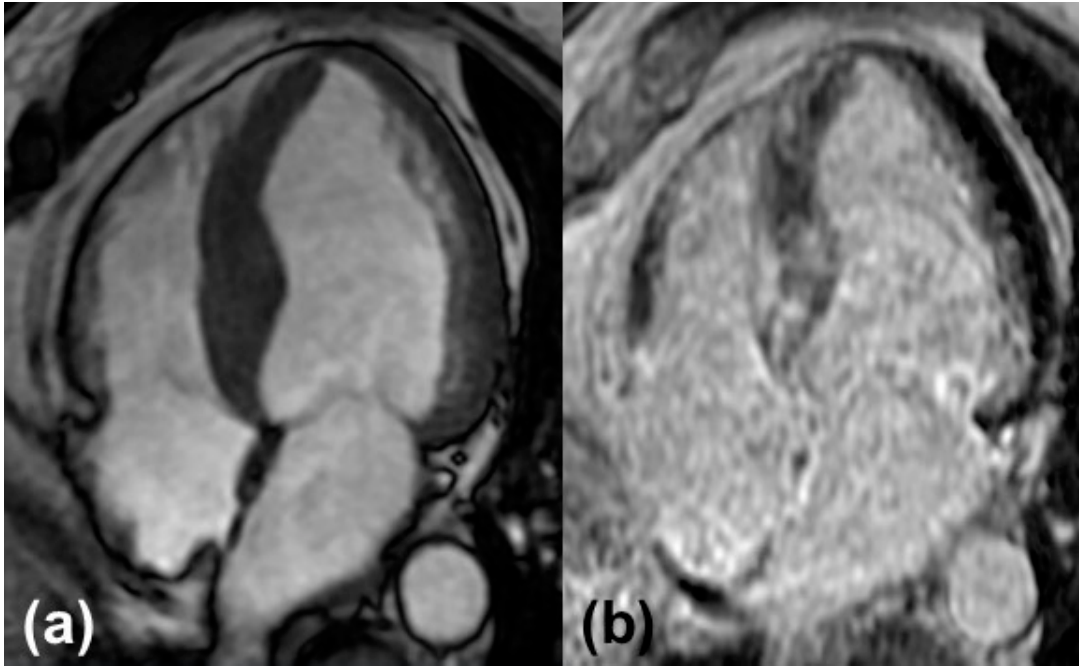
Figure 2. Typical findings in cardiovascular magnetic resonance: ( a ) Cine image of a four-chamber view with left ventricular hypertrophy. ( b ) Late gadolinium enhancement of the left and right ventricular myocardium.